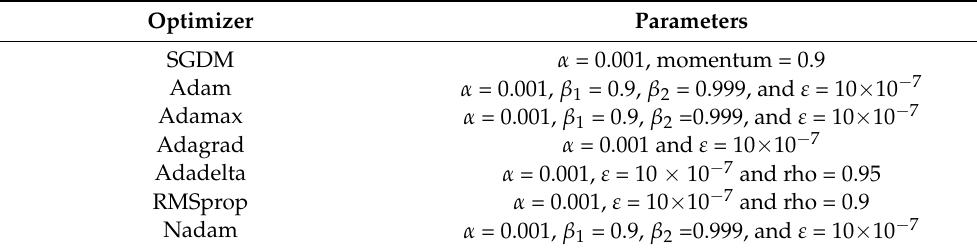
Table 4. Parameter settings of